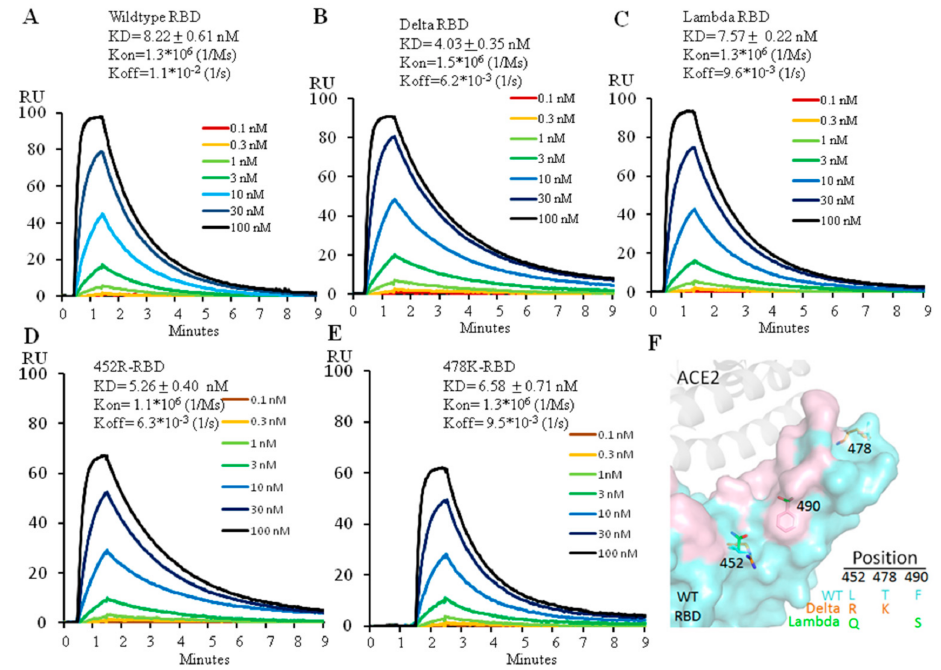
Figure 1. Affinity measurement of ACE2 binding to wild type ( A ), Delta ( B ), Lambda ( C ), 452R ( D ) or 478K ( E ) RBD using Biacore. The protein model for RBD and ACE2 is shown in ( F ) with the ACE2 footprint in pink. 6M0J (PDB ID) was used for